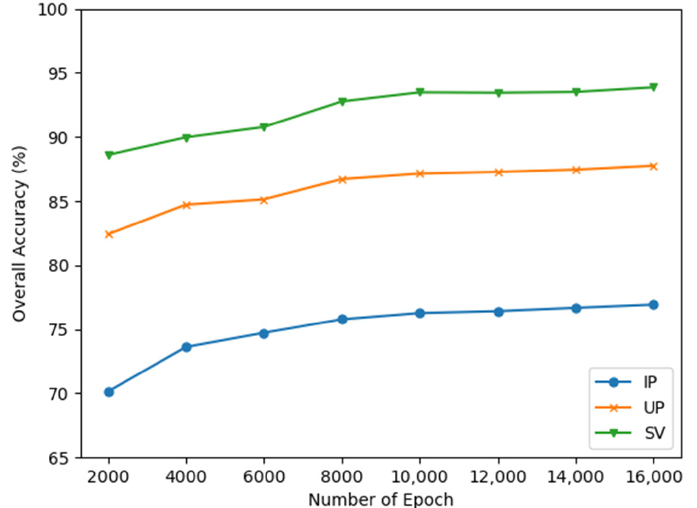
Figure 10. OAs obtained by GDAFSL with different numbers of epochs on three target datasets.